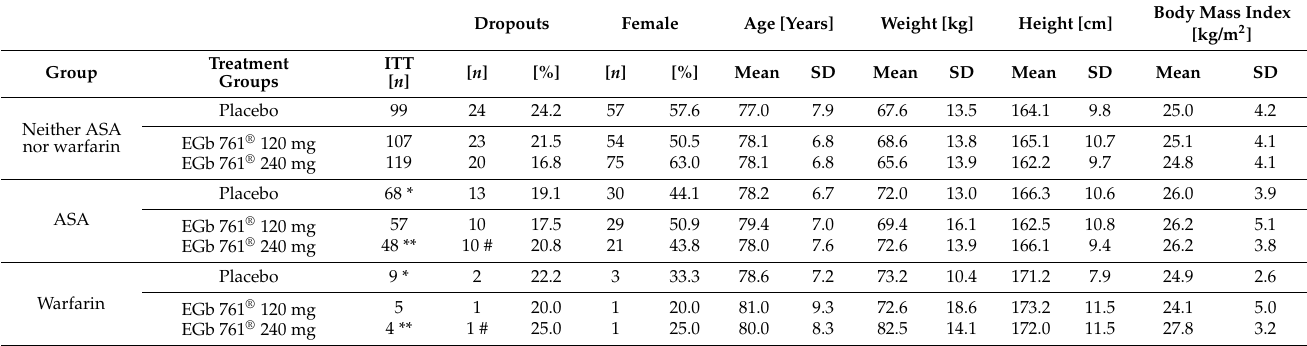
Table 1. Demographic data shown by concomitant use of anticoagulants and per treatment